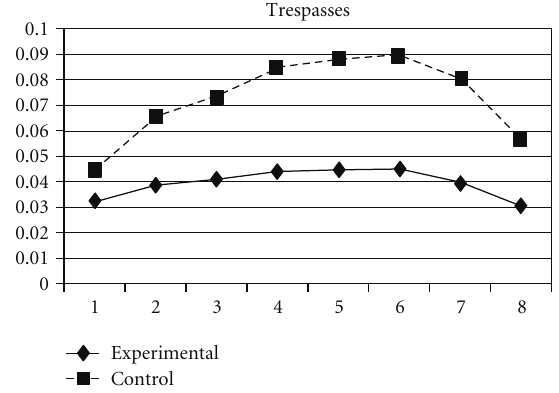
Figure 5: Growth trajectories of the experimental group (all partic- ipants) and control group using the item score of trespasses as the outcome indicator.